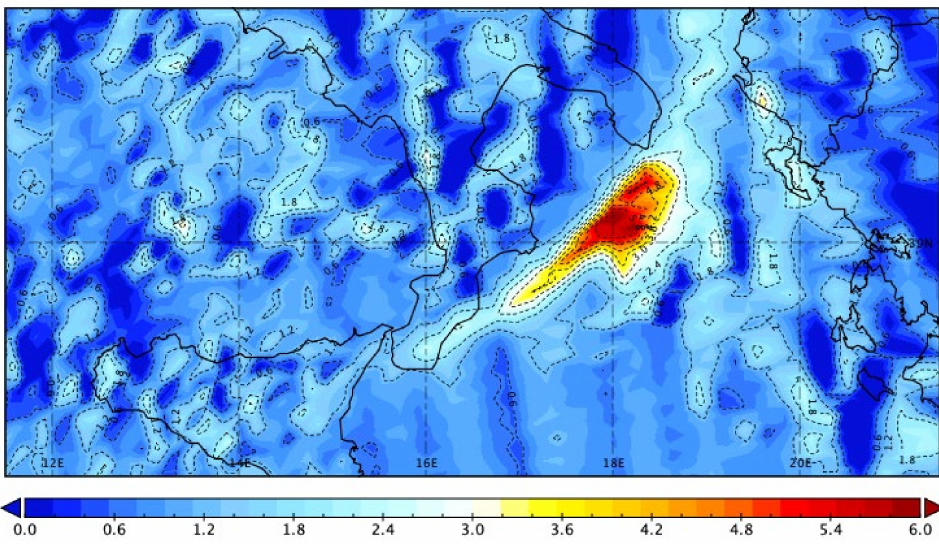
Figure 9. Suomi NPP OMPS Aerosol Index. Data are for Orbit L2 Swath 50 × 50 km, time coverage from 11:38:39 to 12:28:30 on 23 November